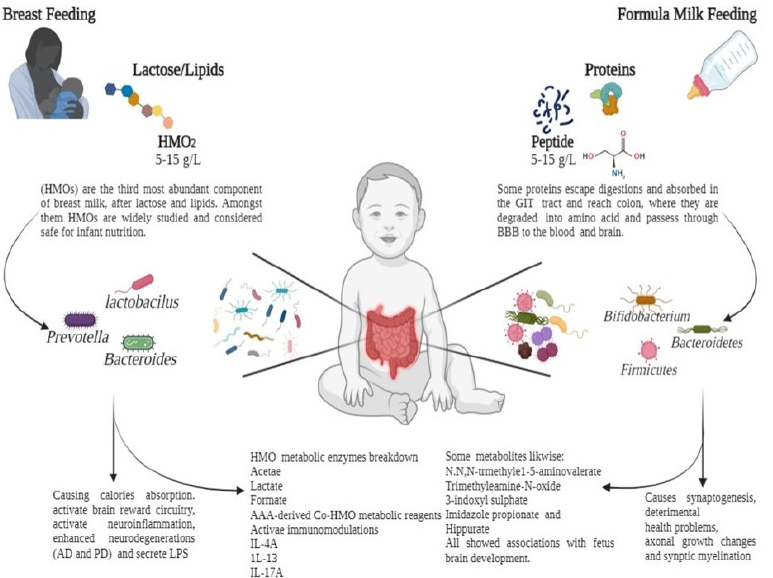
Figure 2. Feeding patterns influence the human gut microbiota via the fermentation of carbohydrates and proteins in early breast milk. Breast milk contains human oligosaccharides (HMOs), which pass undigested through the upper gastrointestinal (GI) tract to the colon. Here, they are digested by specific HMO-degrading microbial species ( Lactobacillus, Bifidobacterium, and Firmicutes ) into various useful metabolites. Upon ingestion, formula milk with excess proteins reaches the colon via the GI tract. Proteins, peptides, and individual amino acids are catabolized by gut microbiomes such as Enterobacteriaceae and Clostridium species. From breastfeeding to formula feeding, the infant is exposed to gut microbiota and metabolites, which contribute to immune regulation and neural development.